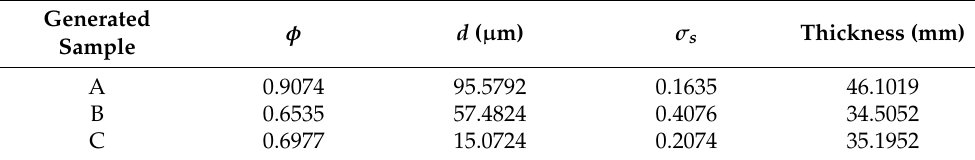
Table 5. Randomly generated physical parameters of fibrous metal felts for numerical